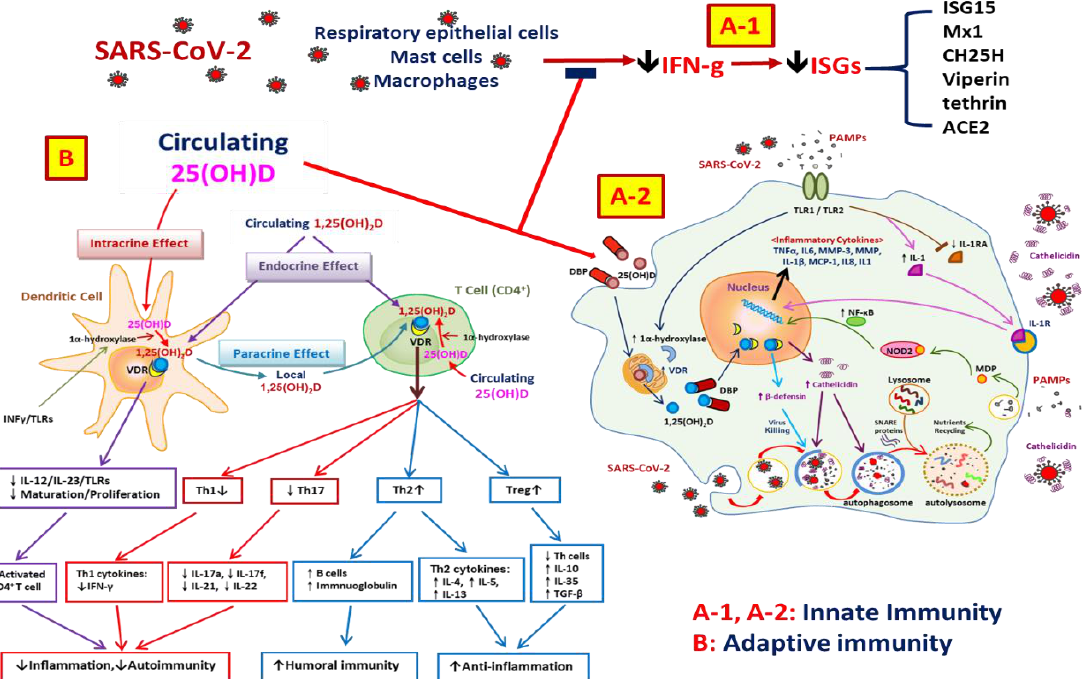
Figure 2. ( A ) Vitamin D-related innate immunity. SARS-CoV-2 viral proteins are able to inhibit var-